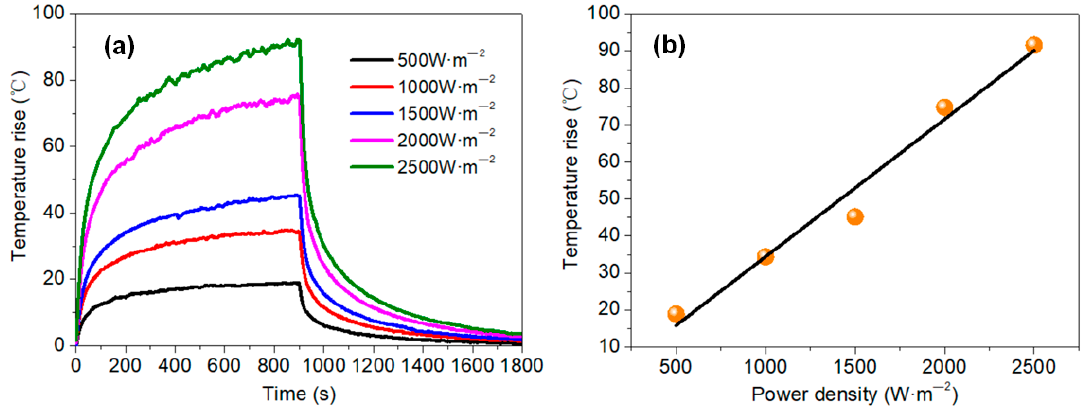
Figure 14. ( a ) Electric heating property of the 8 g · m − 2 membrane with different power density; ( b ) Relation between temperature rise of the membrane and power density.